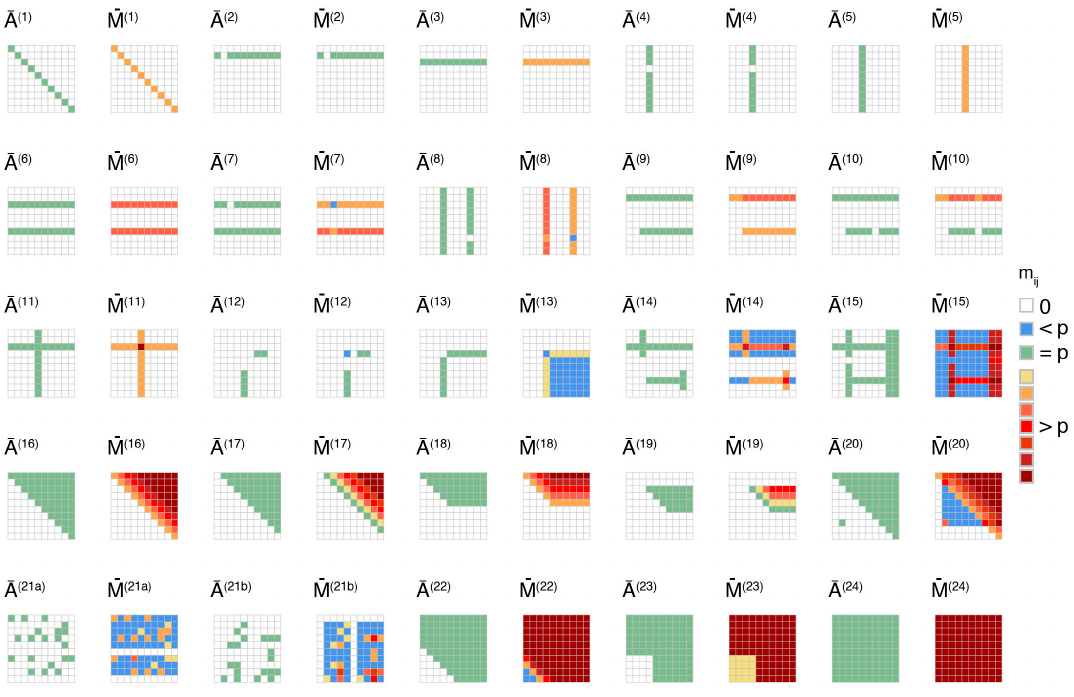
Figure 2. Different topologies (cid:1864) of one-to-one interactions in a reduced adjacency matrix (cid:2157)(cid:3365) ((cid:3039)) and Figure 2. Di ff erent topologies l of one-to-one interactions in a reduced adjacency matrix A matching reduced interaction matrix (cid:2169)(cid:3365) ((cid:3039)) ( max (cid:2028) = 10) . Warmer colors are proportional to the ad-hoc ( l ) ( max τ = 10 ) . Warmer colors are proportional to the ad-hoc matching reduced interaction matrix M probability, here fixed to (cid:1868) = 0.1 . probability, here fixed to p =